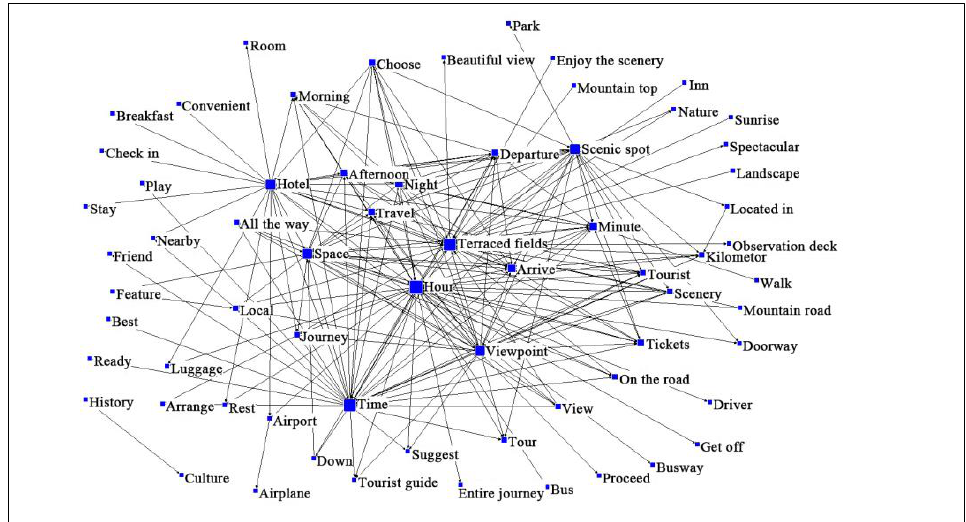
Figure 4. Semantic network diagram.